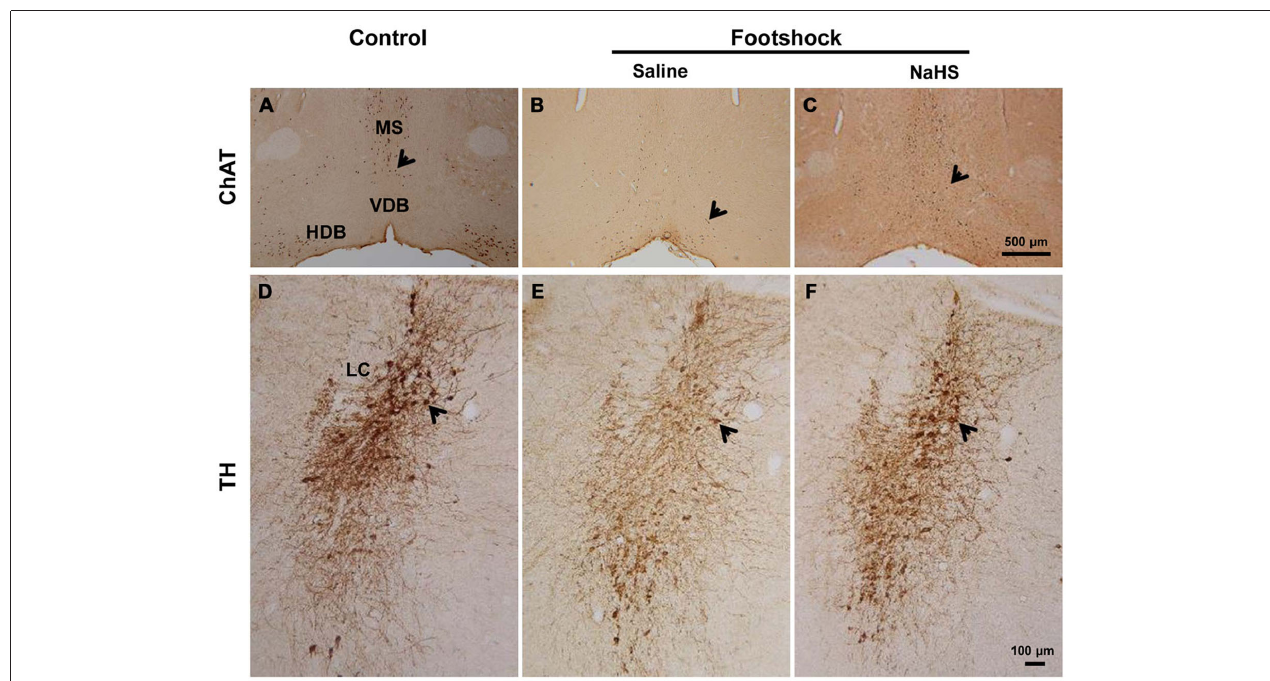
FIGURE 11 | NaHS prevented cholinergic and noradrenergic neuronal loss in mice under footshock. (A-C) Representative photomicrographs of cholinergic neurons (ChAT staining) in the medial septum/diagonal band of Broca (MS/DB). Scale bar: 500 µ M. (D-F) Representative photomicrographs of noradrenergic neurons (TH staining) in the locus coeruleus (LC). Scale bar = 100 µ m. Positive staining is indicated by arrows. n = 3–5 per